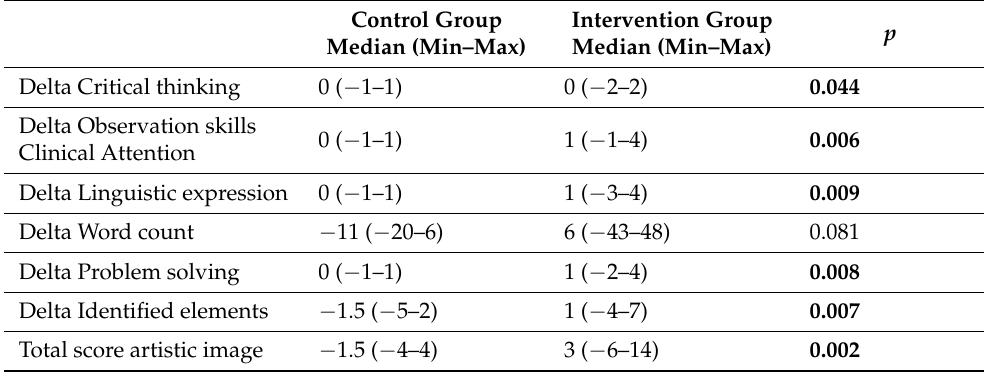
Table 2. Results related to artistic image.